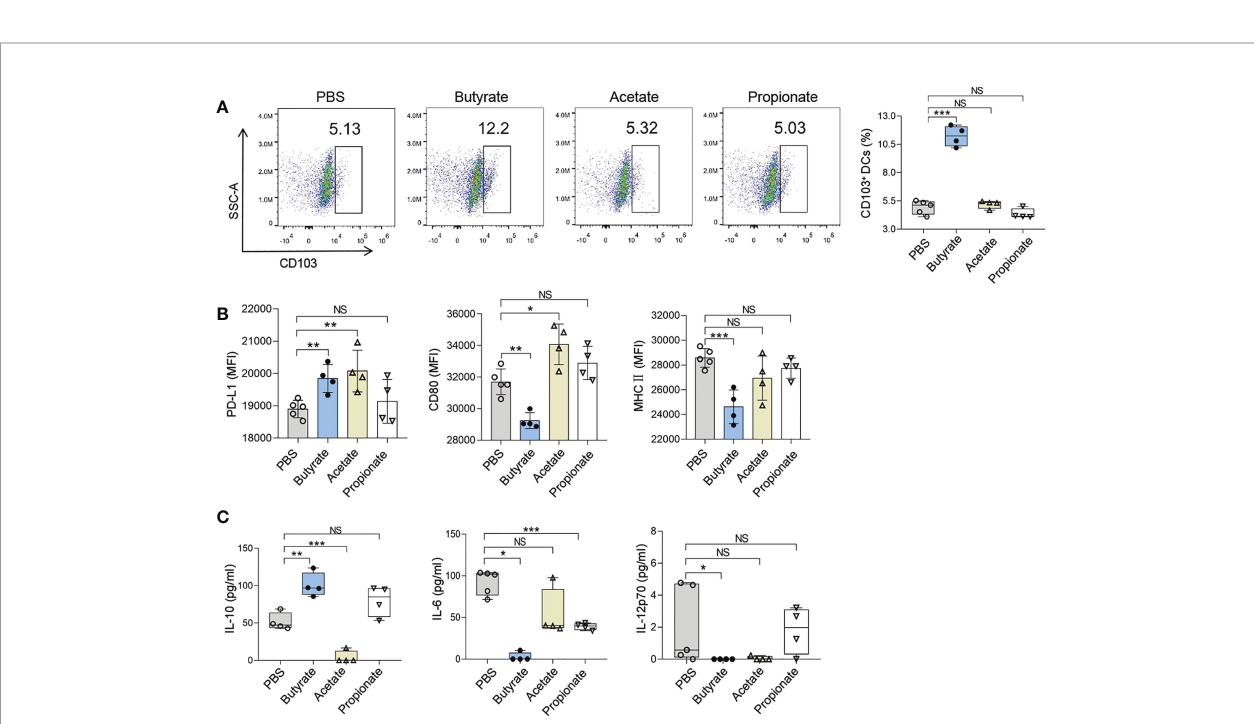
FIGURE 5 | Butyrate promotes the ex vivo induction of DCregs. CD11c + DCs from the spleen of naive mice were incubated with SCFAs for 24 h. (A) Numbers of CD103 + DCs (CD11c + MHCII + CD103 + ) were measured by fl ow cytometry. (B) MFIs of CD80, MHCII, or PD-L1 on CD11c + DCs were measured by fl ow cytometry. (C) Levels of IL-6, IL-10, and IL-12p70 in the supernatants of CD11c + DCs were measured by ELISA. Data are shown as means ± SEMs, and representative of data from three independent experiments. Student ’ s t-test (unpaired; n = 4~5); *P < 0.05, **P < 0.01, ***P < 0.001 vs. PBS group. NS, not signi fi